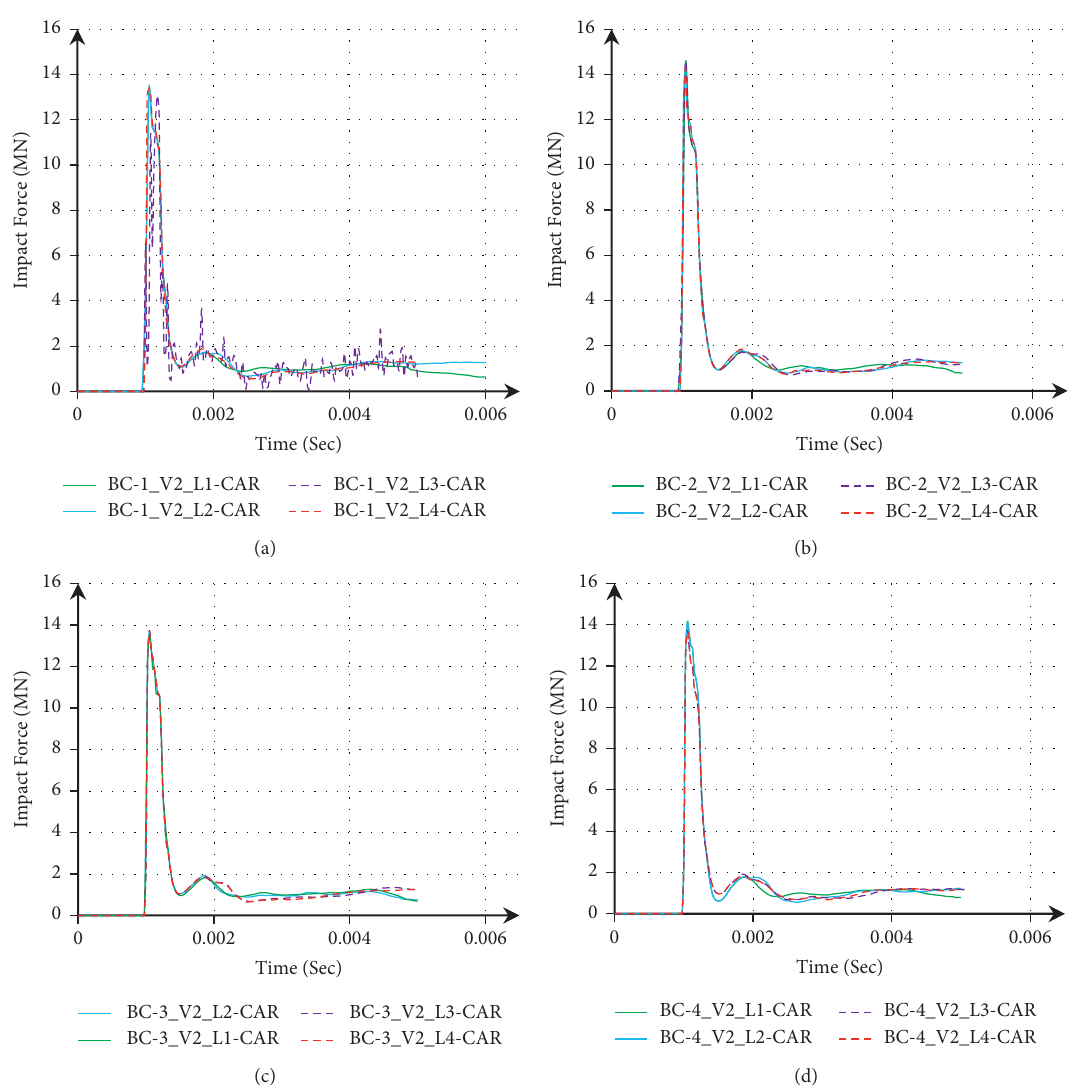
Figure 15: Effect of axial load on single impact capacity of BRC columns. (a) Without bundling (BC-1). (b) Two-bundle system (BC-2). (c) Three-bundle system (BC-3). (d) Four-bundle system